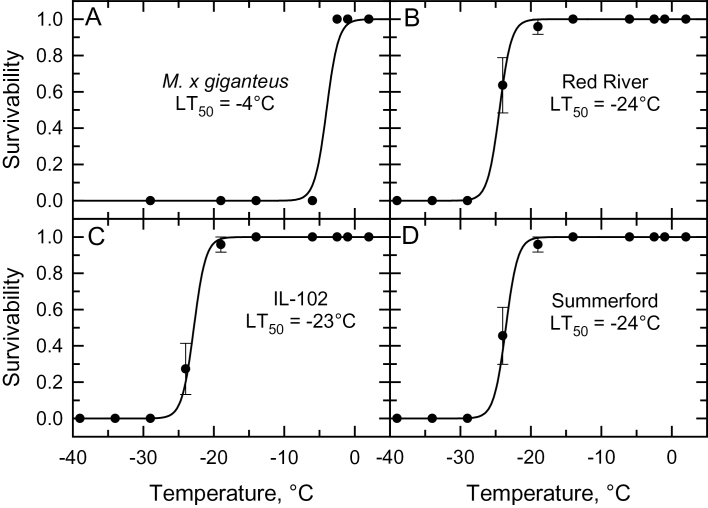
The relationship between exposure temperature and the % of rhizome survival for the autumn and winter sampling dates. (A) Results from Miscanthus × giganteus. (B–D) Results from the ‘Red River’, ‘IL-102’ and ‘Summerford’ accessions of Spartina pectinata. Each symbol is the pooled mean ±SE of the available rhizomes from plants harvested on 21 November 2013 (autumn harvest) and 2 February 2014 (winter harvest). n=11–24 rhizomes per treatment temperature. The estimated temperatures corresponding to 50% rhizome mortality (LT50) are shown in each panel. The trend line is the predicted relationship using a generalized linear model fitted to the data. See online Supplementary Tables S1 and S2 for means of autumn and winter data.